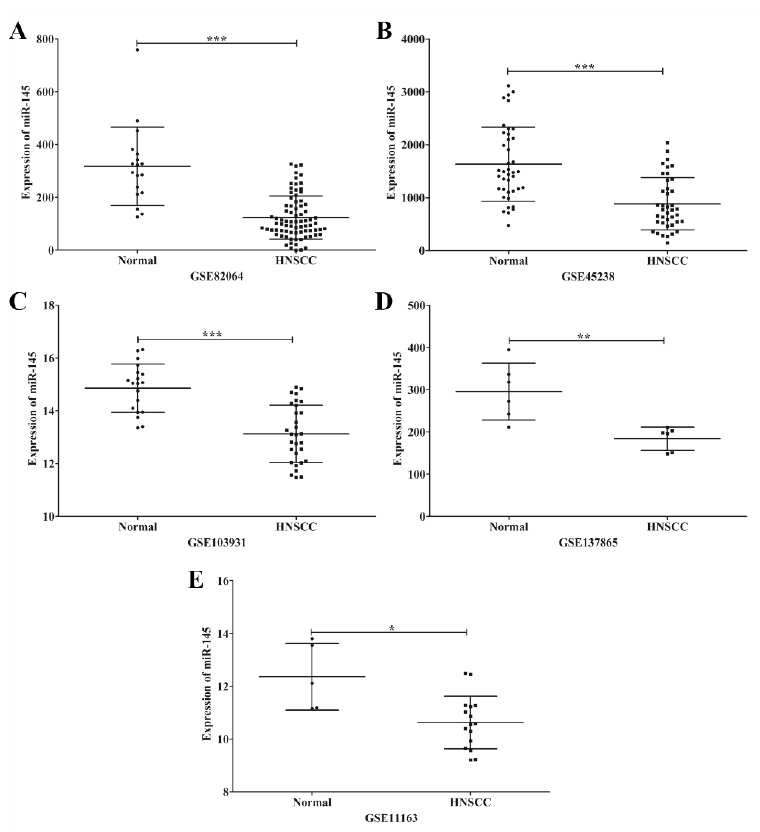
Figure 2. Representative scatter plots of miR-145 expression in normal and HNSCC tissues in microarrays. Expression levels of miR-145 in normal and HNSCC tissues plotted from microarray data; GSE82064 ( A ), GSE45238 ( B ), GSE103931 ( C ), GSE137865 ( D ) and GSE11163 ( E ). *: p < 0.05; **: p < 0.01; ***: p < 0.001.